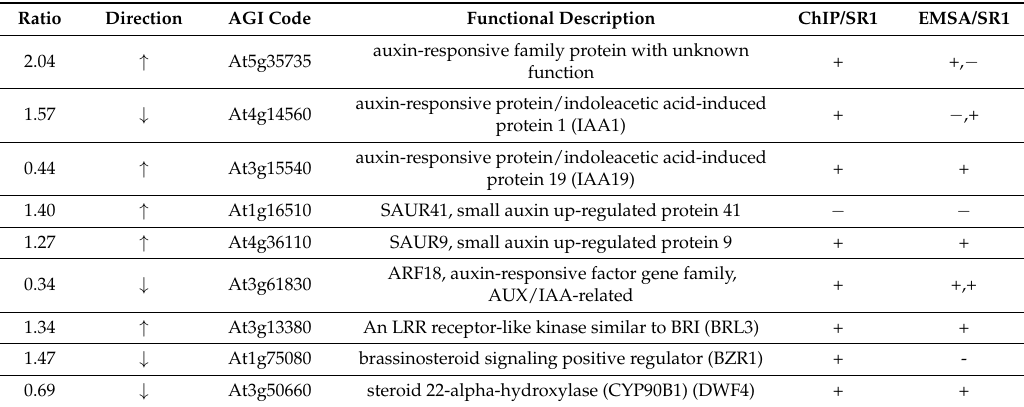
Table 2. Putative AtSR1 target genes related to actions of growth